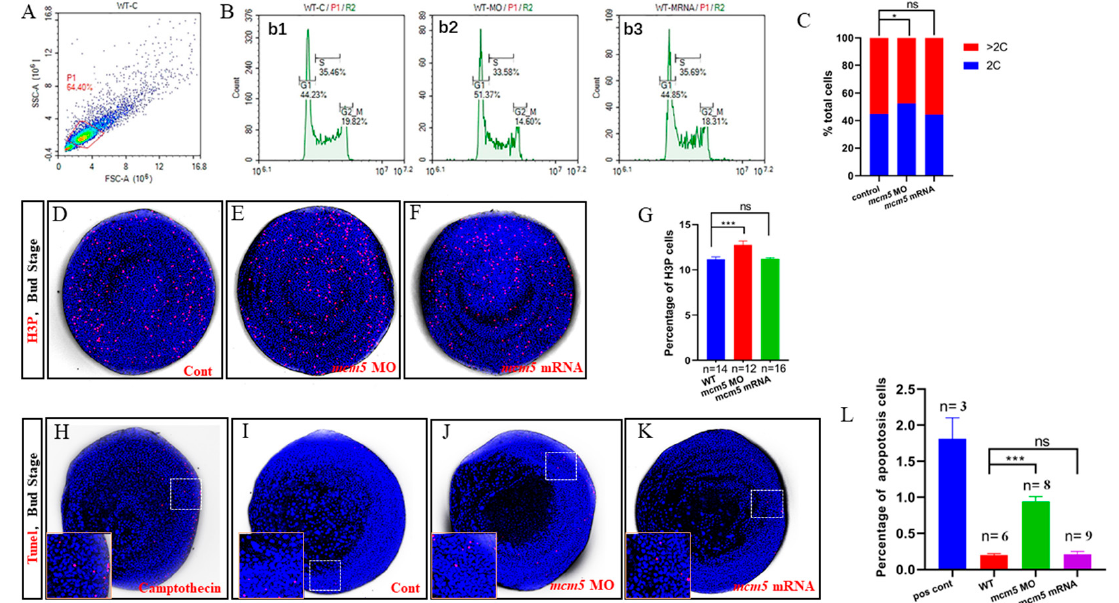
Figure 3. mcm5 loss of function, but not overexpression, leads to cell cycle arrest and cell apoptosis at the bud stage. ( A – C ) Flow cytometry analysis showed that 44.23% of cells in control embryos were in the G1 phase at the bud stage ( Bb1 , C , n = 3), 51.37% of cells in mcm5 morphants were in the G1 phase ( Bb2 , C , n = 3, p = 0. 023), and 44.85% of cells in embryos injected with mcm5 mRNA were in the G1 phase ( Bb3 , C , n = 3, p = 0.1). Specifically, 44.2%, 35.4%, and 19.8% of cells in control embryos